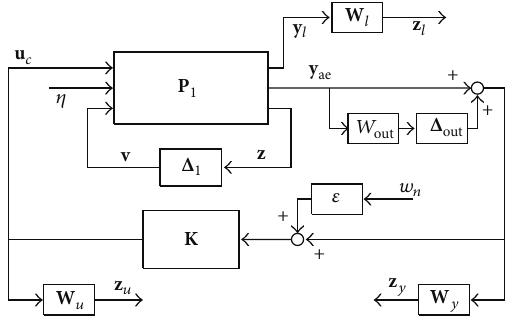
Figure 5: Structure of the closed-loop robust control